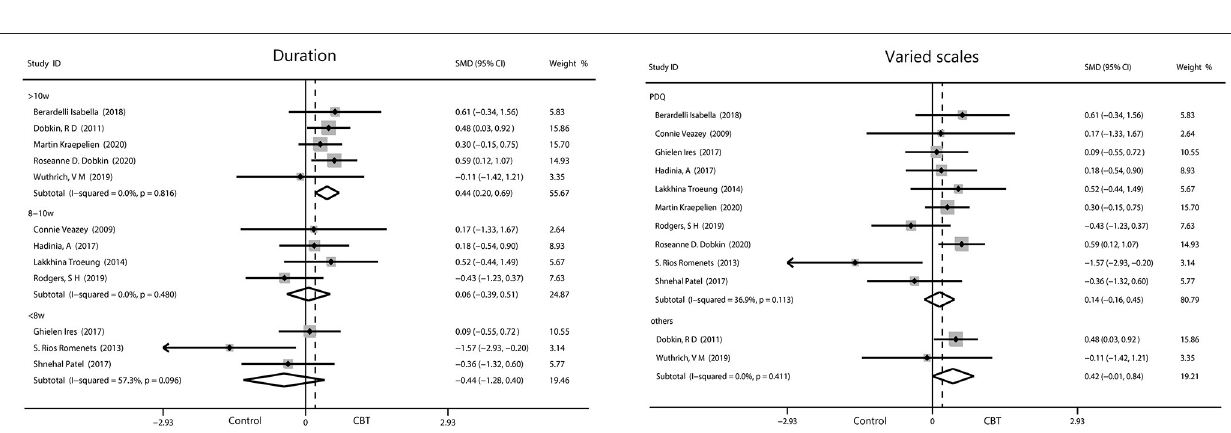
FIGURE 7 | Forest plot of random effects model meta-analysis of the effect of CBT on subgroups of sleep disorders. CBT, cognitive behavioral therapy.